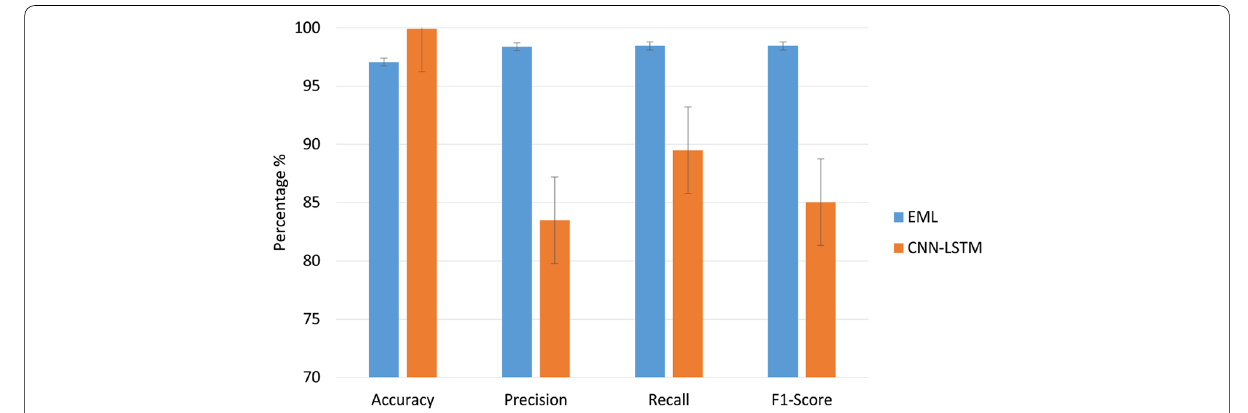
Fig. 7 Performance Metrics Comparison of Proposed